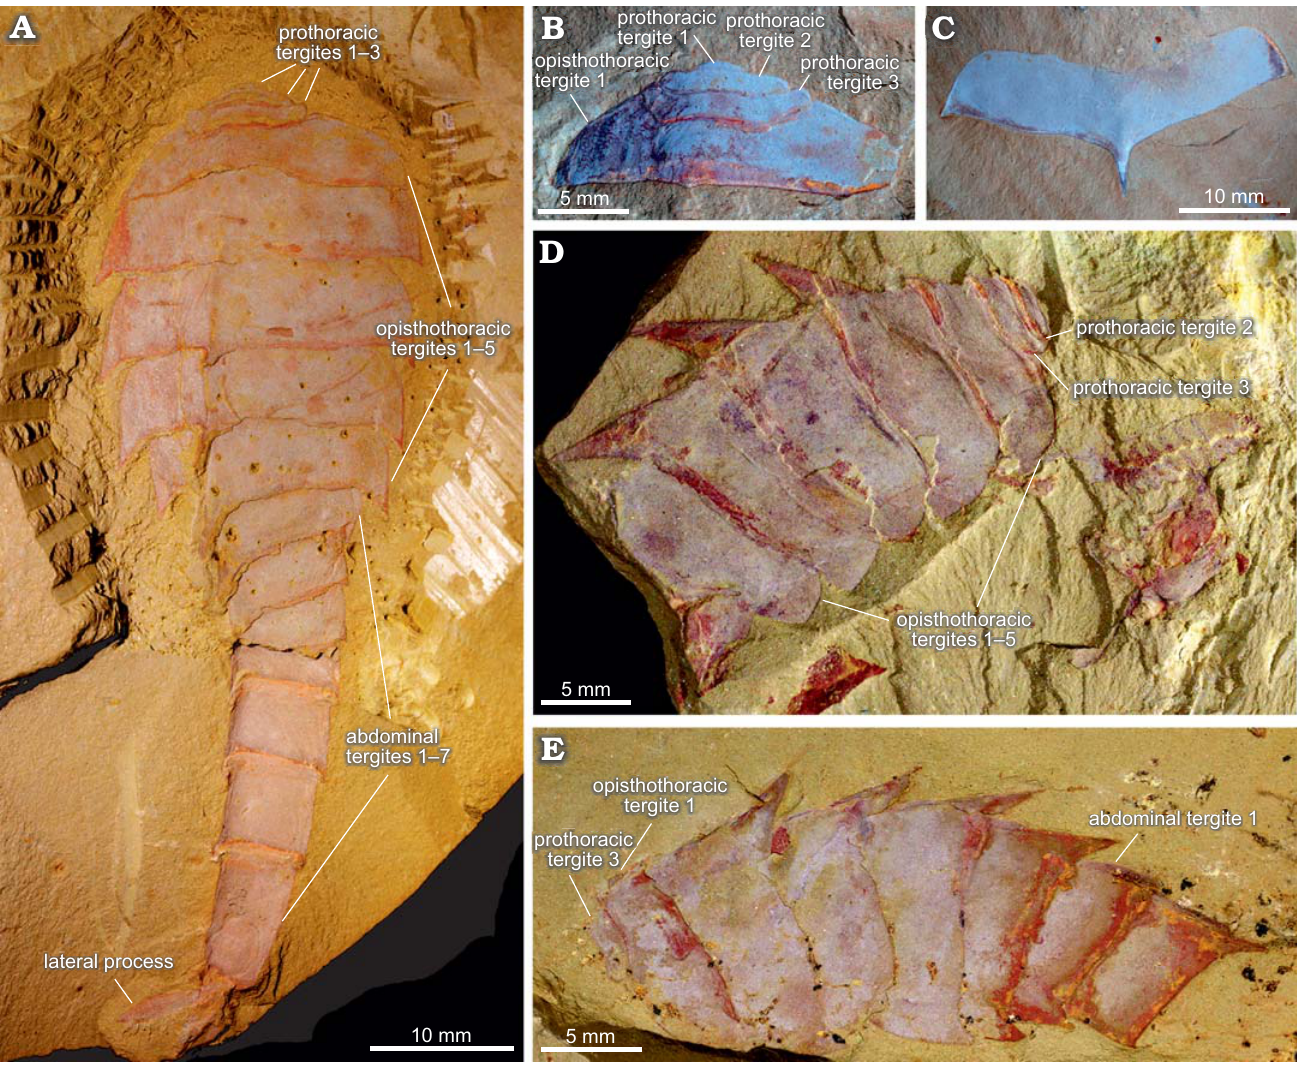
Fig. 1. Tergal morphology of fuxianhuiid arthropod Guangweicaris spinatus Luo, Fu, and Hu in Luo et al., 2007 from the lower Cambrian Guan shan Biota, China. A . YKLP 11564a, a nearly complete specimen in dorsal view, showing three prothoracic tergites, five opisthothoracic tergites and seven abdominal tergites. B . YIGS Kgs-1-36 (paratype), prothoracic tergites in dorsal view. C . YIGS Kgs-1-37 (paratype), isolated opisthothoracic tergite